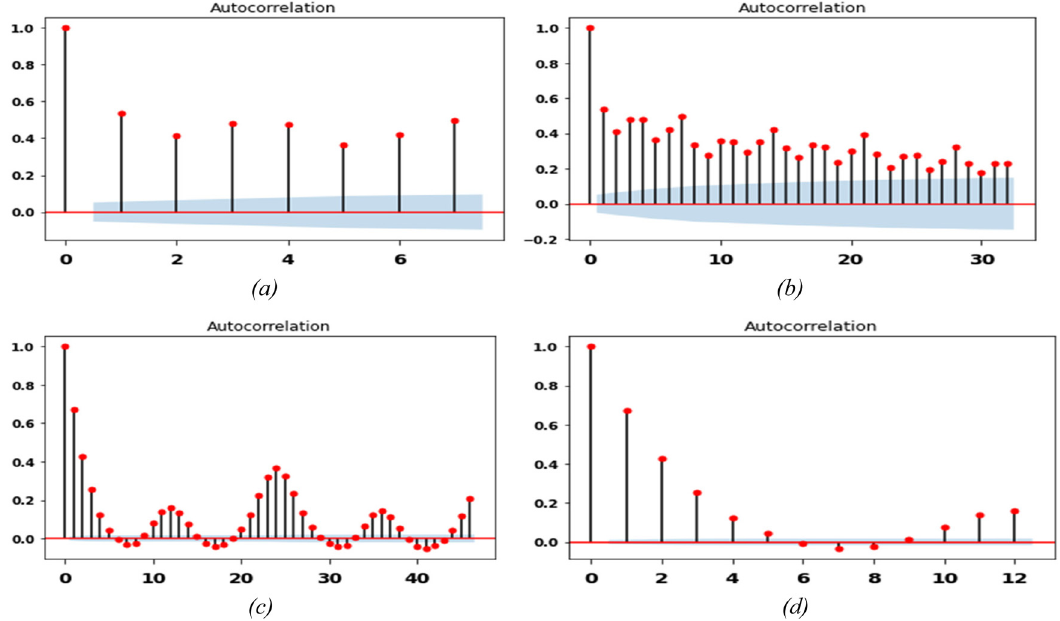
Figure 6: Auto - correlation of time series data resampled to: ( a and b ) daily mean values and ( c and d ) hourly mean